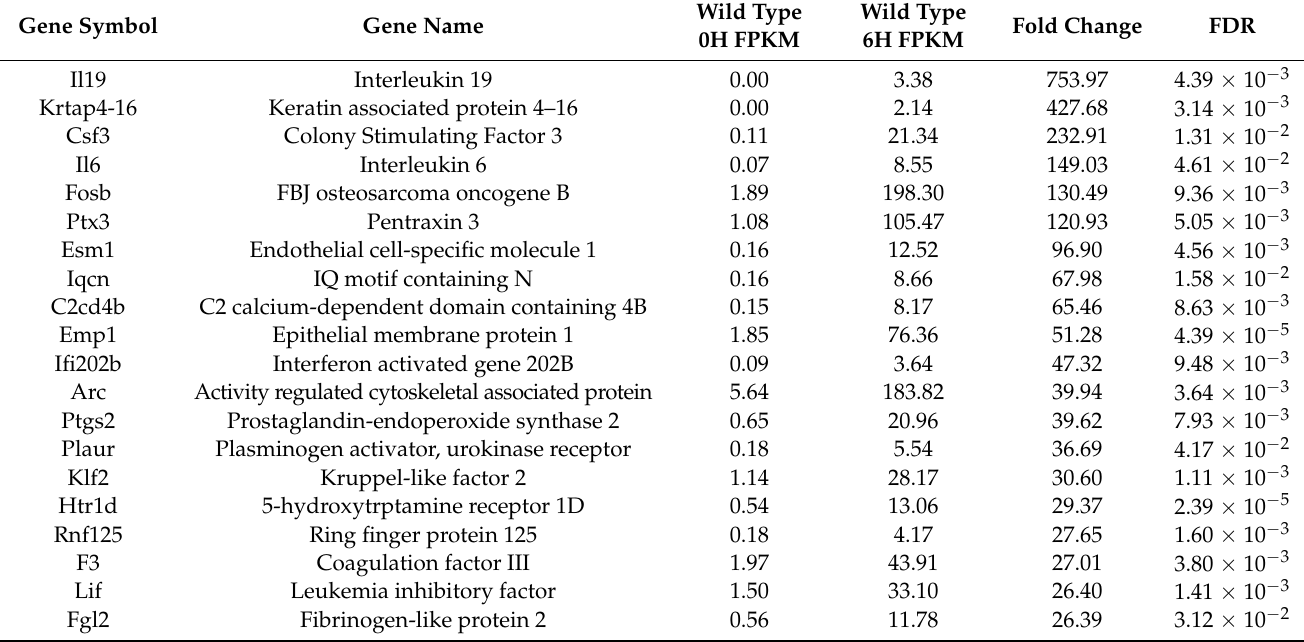
Table 1. Top 20 most upregulated genes in mouse LECs at 6 h PCS.